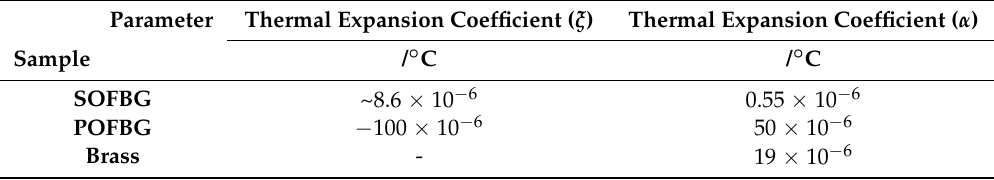
Table 1. Relevant parameters of SOFBG and POFBG